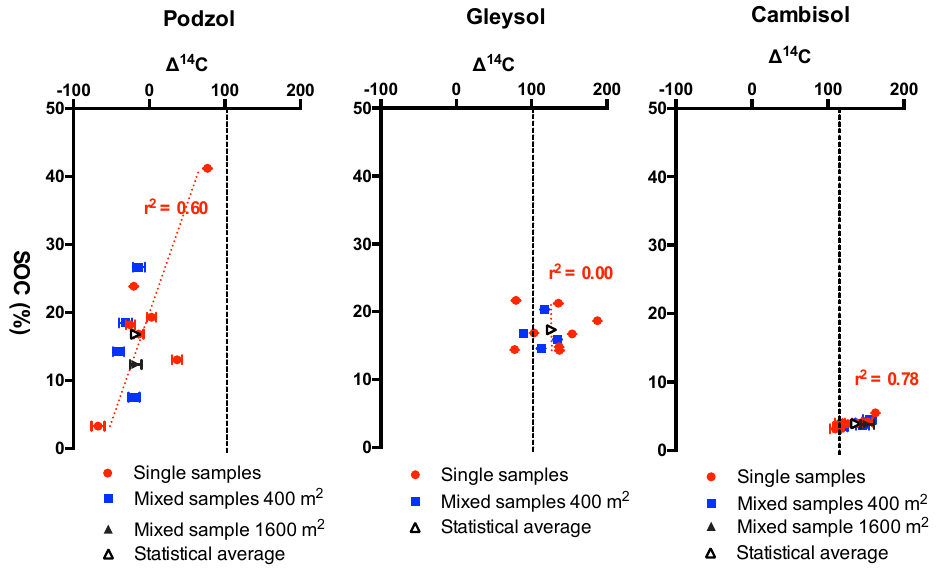
Figure 5. Relationship of (cid:49) 14 C vs. soil organic carbon (SOC) content in topsoil samples (0–5cm) from three sites with decreasing micro- topographic relief from left to right. Error bars indicate analytical error. The pattern shows that single samples can be unrepresentative but careful physical homogenization of soil samples yields almost identical values than the arithmetic average of individual samples. The dashed vertical line in black indicates the (cid:49) 14 C signature of the atmosphere at the time of sampling (Hua et al., 2013). The dotted lines represent the linear regression of (cid:49) 14 C and SOC contents for single sample measurements.